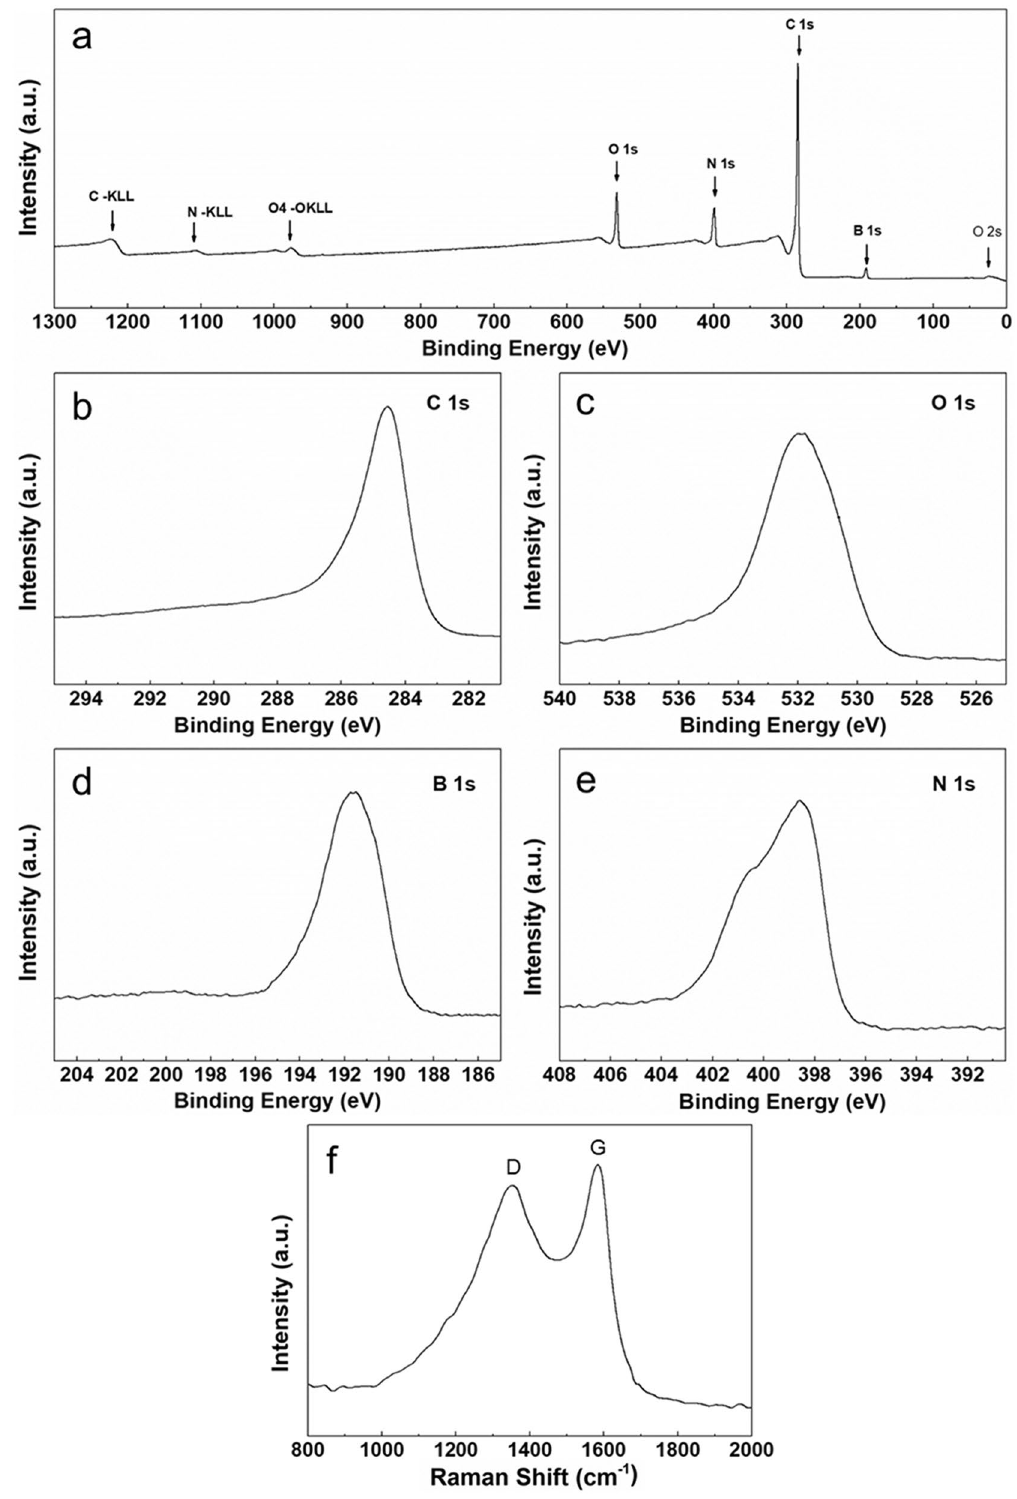
Figure 2. XPS and Raman spectra of NBC@MWCNTs. ( a ) survey spectrum; ( b ) C 1 s spectrum; ( c ) O 1 s spectrum; ( d ) B 1 s spectrum; ( e ) N1s spectrum, and ( f ) Raman spectrum of